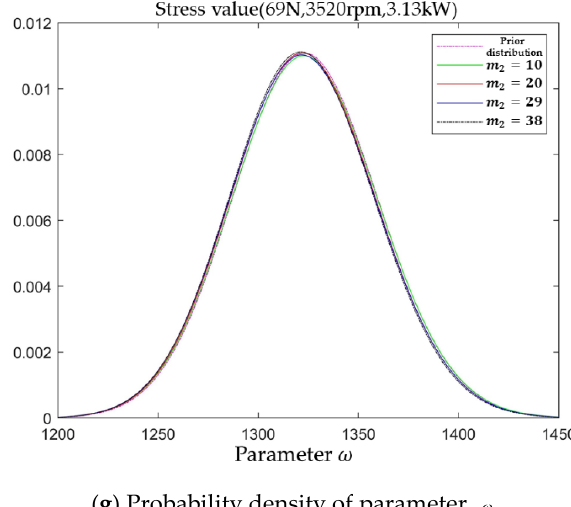
Figure 12. The update process of probability density of each model parameter with the test ( l = 2). In Figure 12 there is a significant change between the posterior distribution probabil-